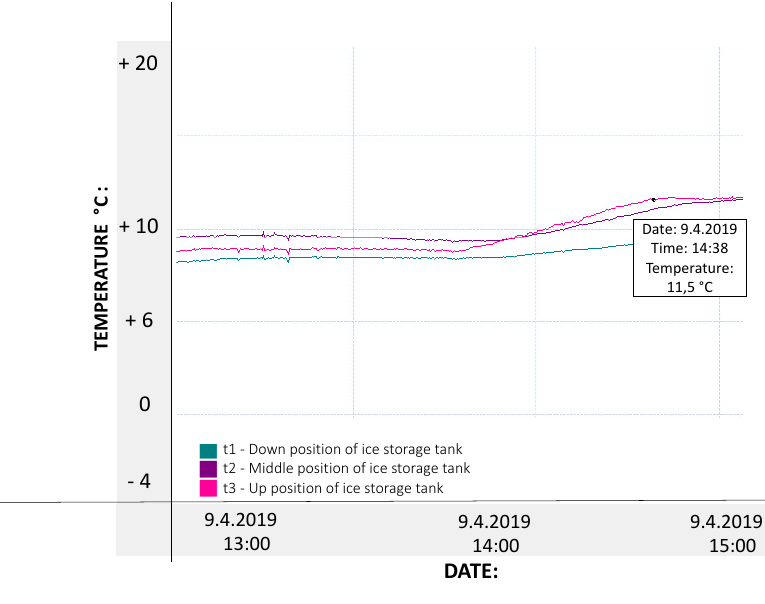
Figure 24. I. Phase 4 +.